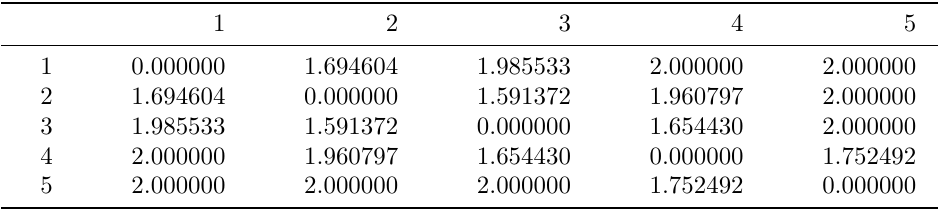
Table 3: Substitution costs between